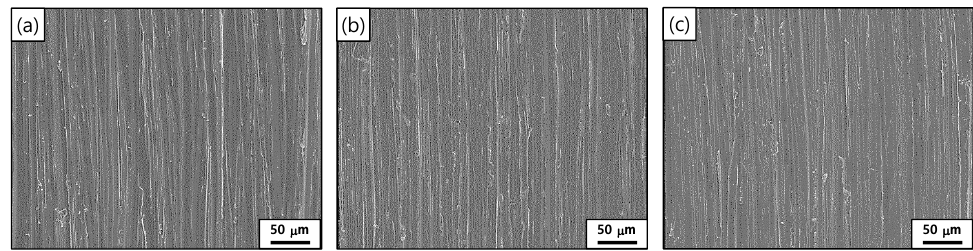
Figure 12. SEM micrographs of the STS 316L corrosion coupon surfaces: ( a ) before the corrosion test; ( b ) after the corrosion test under the stagnant condition for 42 h; ( c ) after the corrosion test under the flowing condition for 42 h.